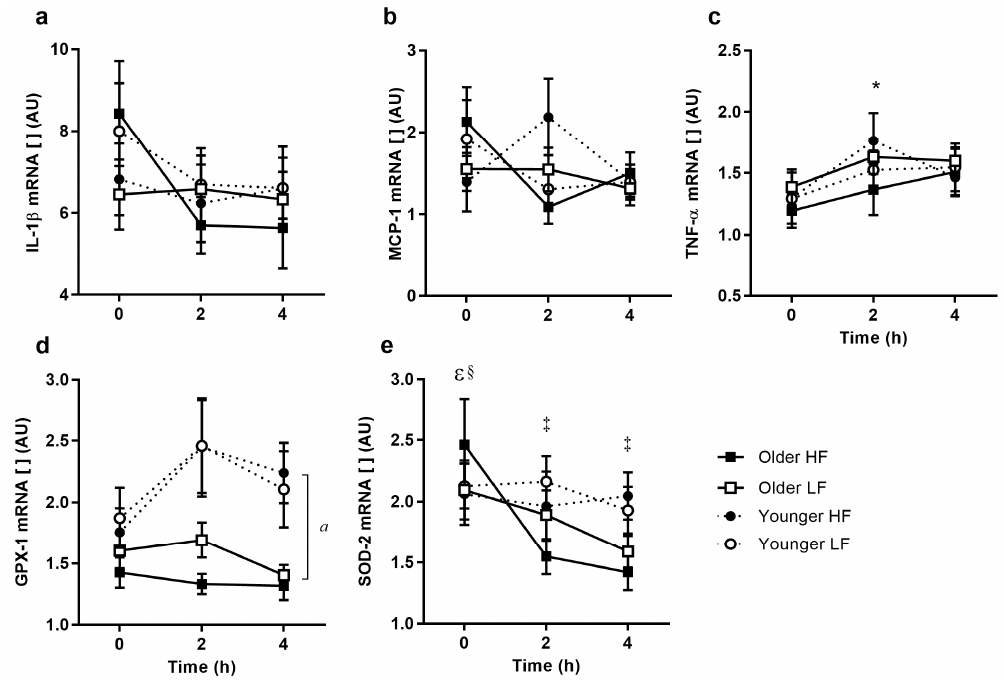
Figure 4. Relative inflammatory cytokine and oxidative stress peripheral blood mononuclear cells (PBMC) gene expression responses to high-fat (HF) and low-fat (LF) breakfasts in older and younger subjects. Older high-fat ( filled squares ), older low-fat ( open squares ), younger high-fat ( filled circles ), and younger low-fat ( open circles ). Values represent mean ± SEM ( n = 15/group) in arbitrary units (AU) for IL-1 β ( a ), MCP-1 ( b ), TNF- α ( c ), GPX-1 ( d ), and SOD-2 ( e ), respectively. There were no differences in IL-1 β , MCP-1, or TNF- α , responses between older and younger subjects. There were significant age differences in GPX-1 gene expression (age effect of p < 0.05 each respectively) and changes over time for IL-1 β and TNF- α (time effect of p < 0.05 each respectively). The SOD-2 response differed over time, dependent on age and treatment (age × time × treatment interaction of p < 0.05, three-factor repeated-measures ANOVA). a p < 0.05 main age difference; * p < 0.05 change from baseline; ε p < 0.05 age difference after LF; § p < 0.05 treatment difference in older subjects; ‡ p < 0.05 time difference